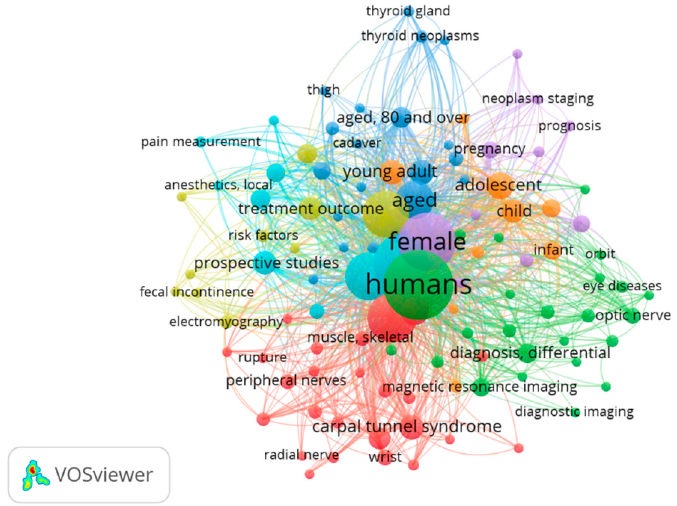
Figure 6. Visualization of keywords for ultrasound examination and nerve.